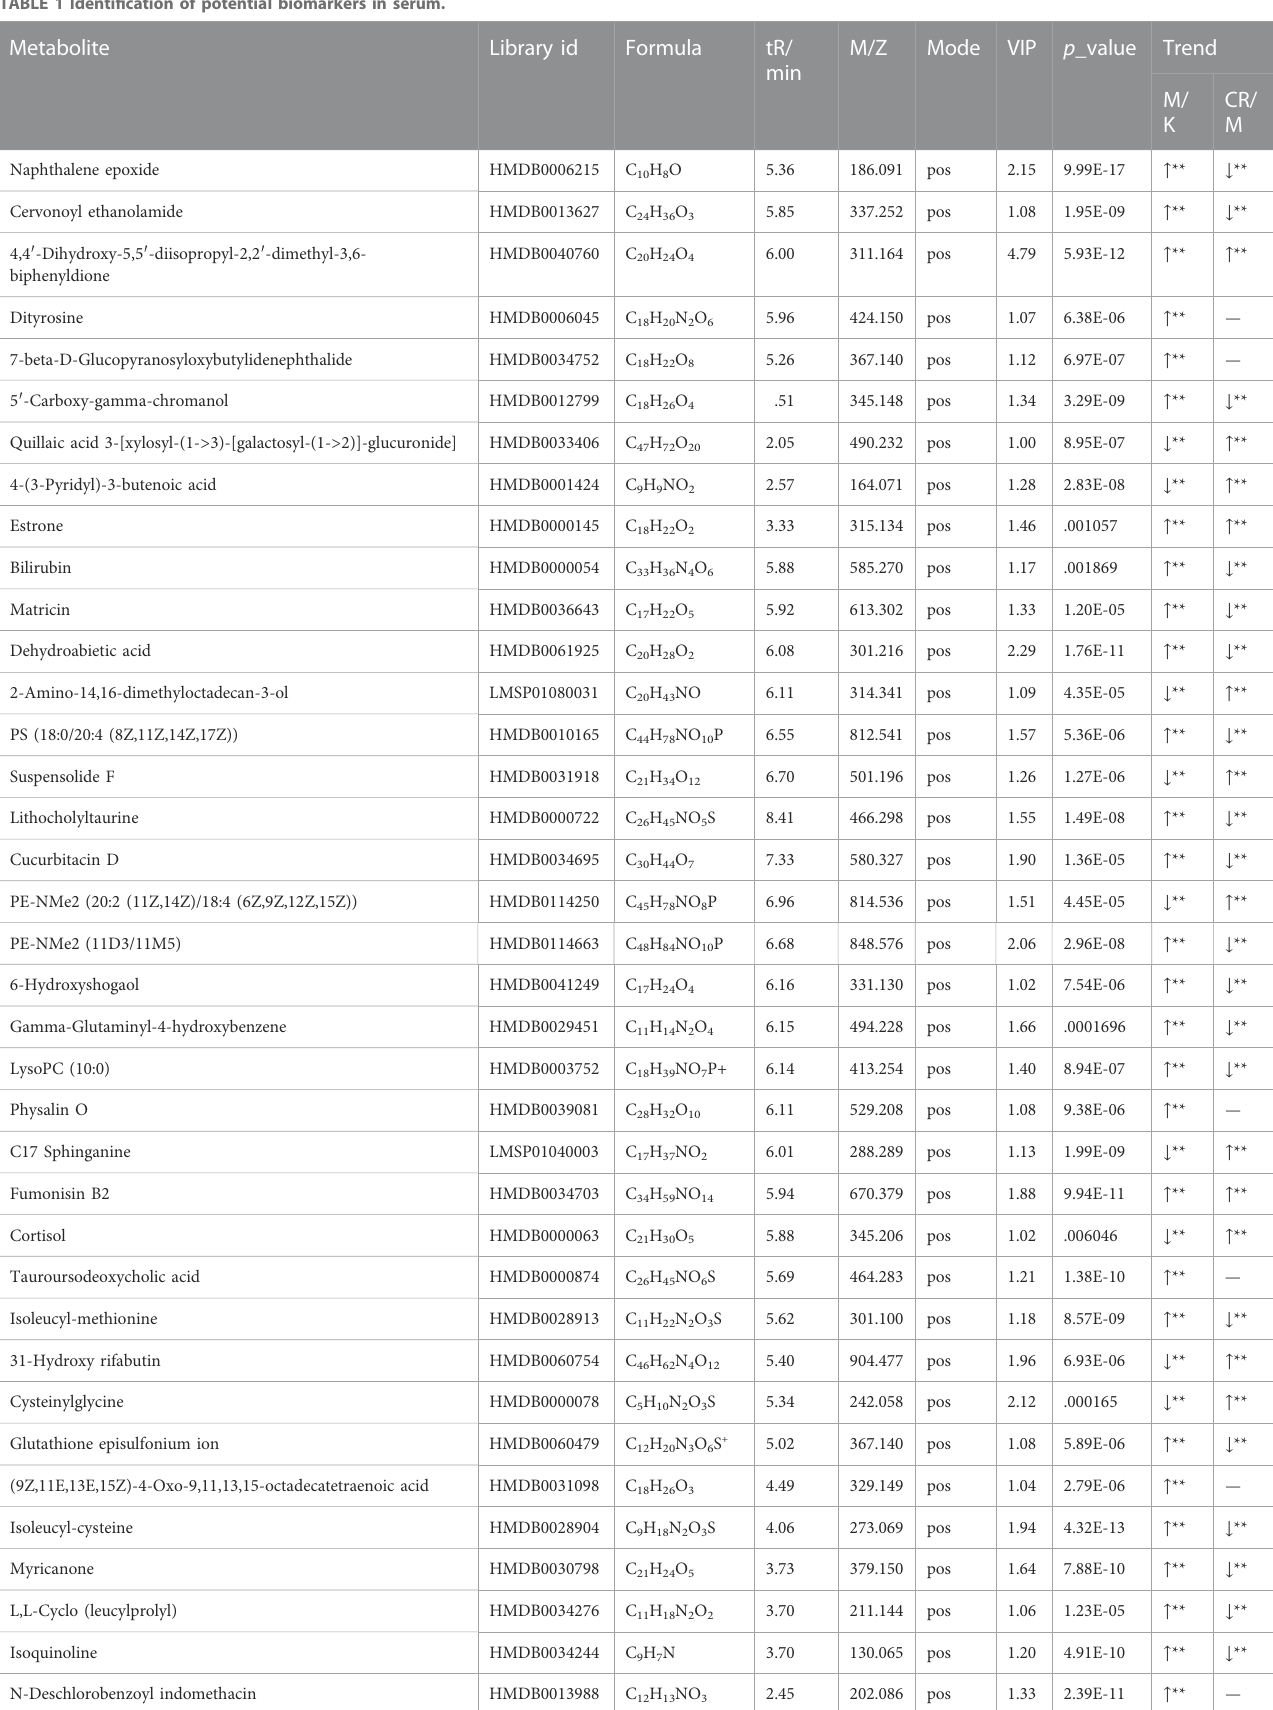
TABLE 1 Identi fi cation of potential biomarkers in